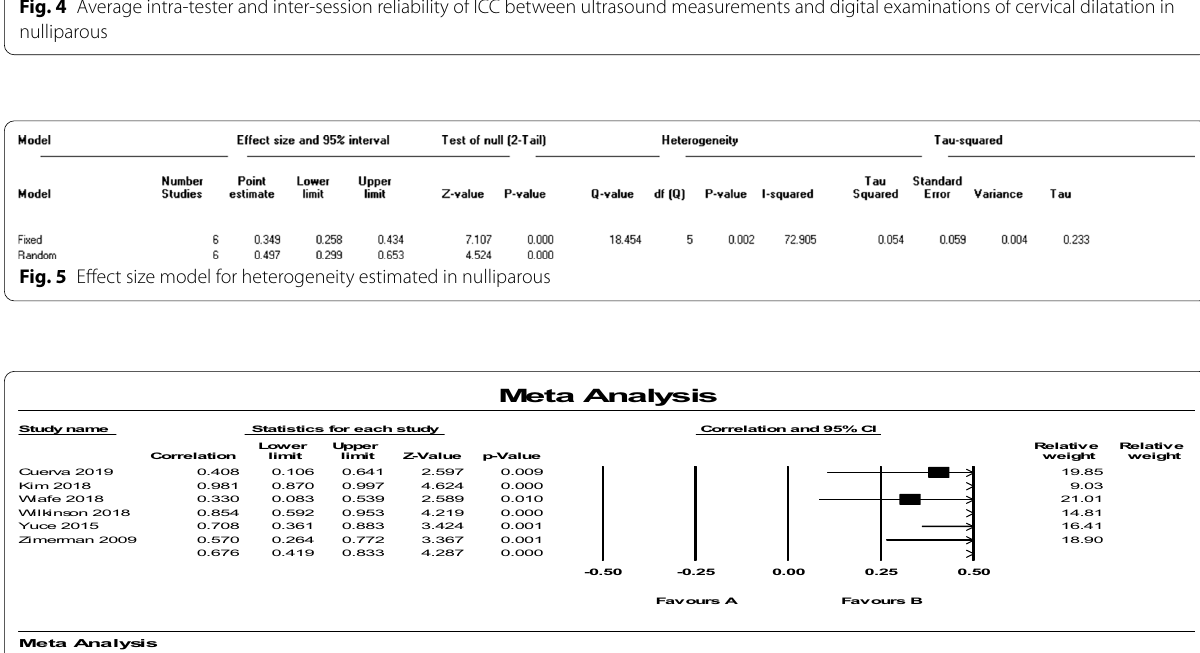
Fig. 6 Average intra-tester and inter-session reliability of ICC between ultrasound measurements and digital examinations of cervical dilatation in